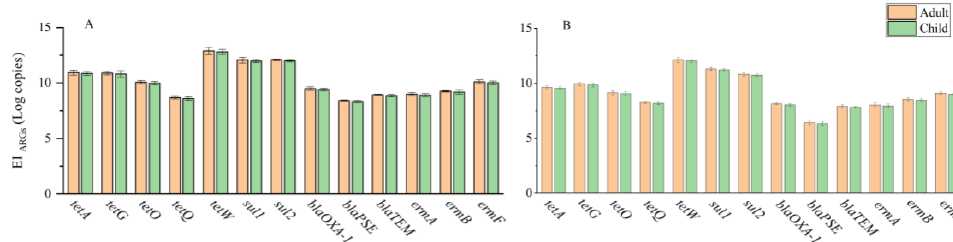
Figure 4. The estimated daily intake of ARGs (EI ARGs ) for adults and children from consuming con- taminated water dropwort roots ( A ) or stems/leaves ( B